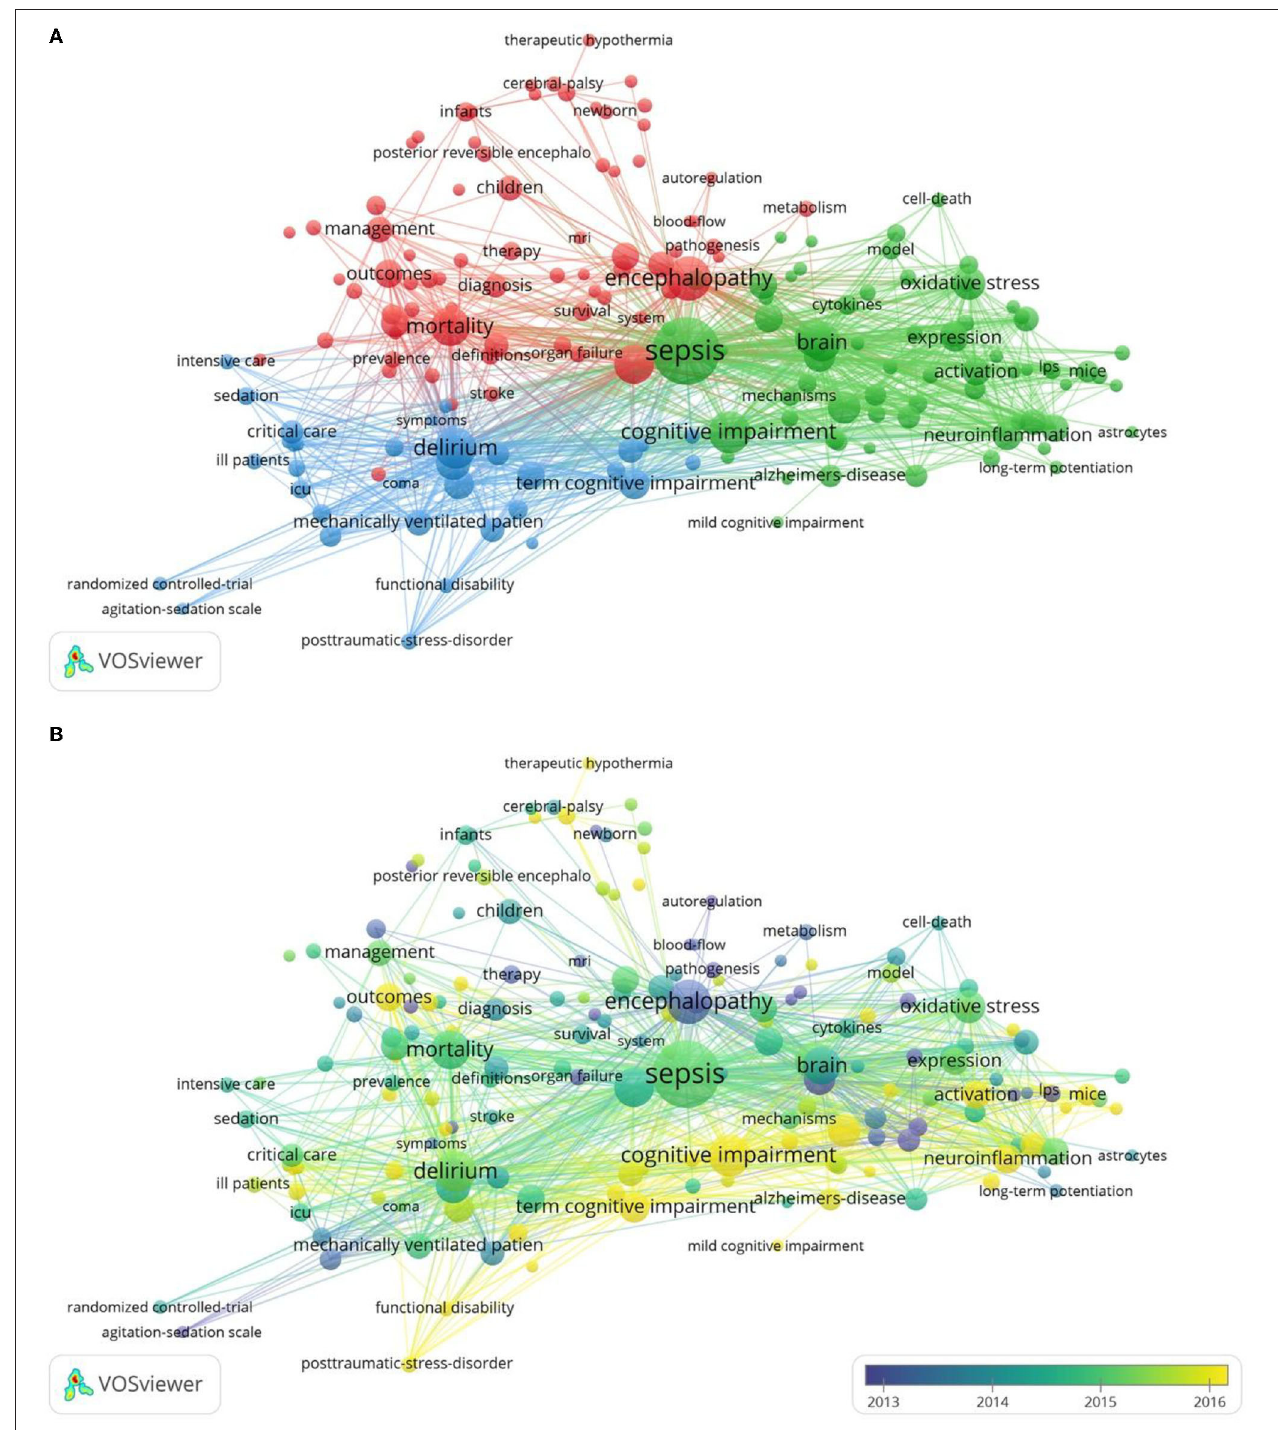
FIGURE 2 | The network map of keyword clustering showed 182 keywords with a minimal occurrence of 15 times and classified into 3 clusters (A) and their average publication year (B) .